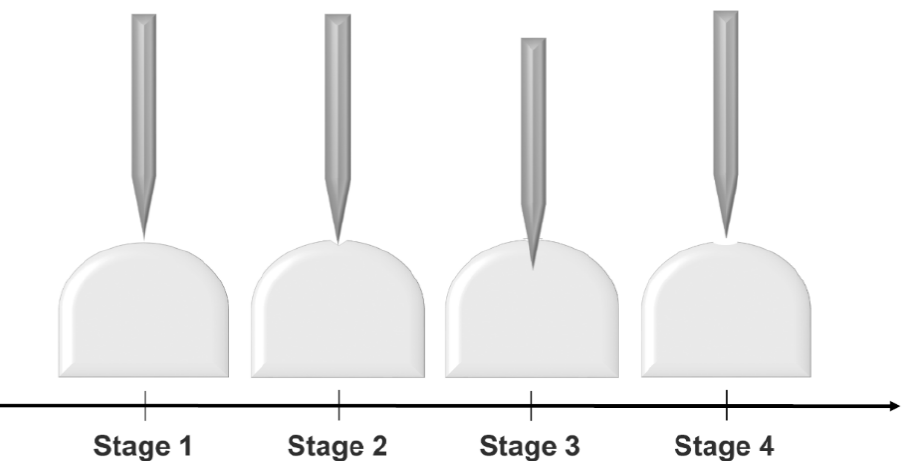
Figure 3. Puncturing process of the capsule. Stage 1: the initial interaction of the pin and the capsule. Stage 2: the pin expose forces to the intact capsule shell. Stage 3: the pin punctures the capsule shell and keeps entering. Stage 4: the pin is removed from the pierced capsule.